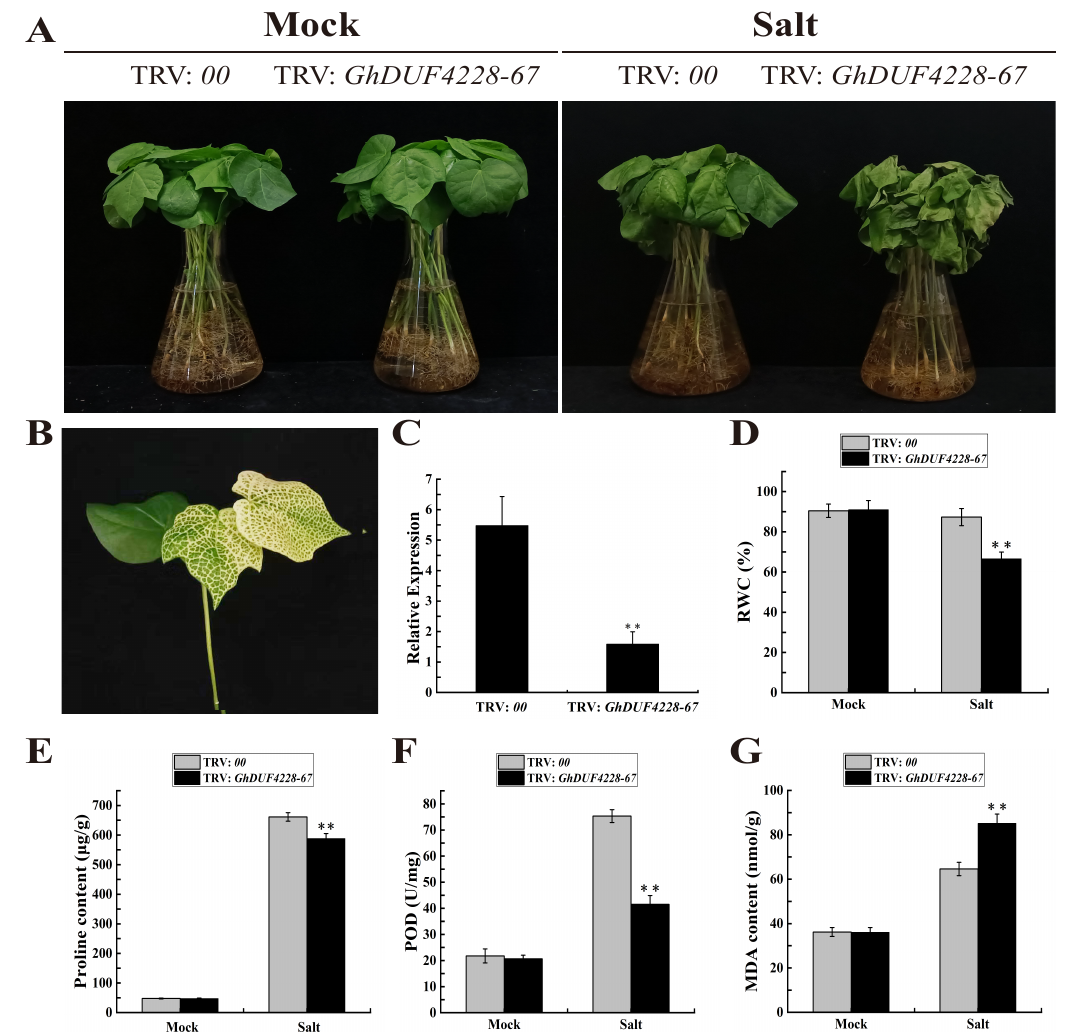
TRV: 00 plants (Figure 8E), the POD activity was only 1/2 of the TRV: 00 plants (Figure 8F), while the MDA content of the gene-silenced plants was 20 nm/g higher than that of the TRV: 00 plants (Figure 8G). The content of MDA indirectly reflects the damage degree to plant cells, and POD is one of the key enzymes of the enzymatic defense system of plants under adverse conditions. Generally, the proline content of plants is low, but it accumulates in large quantities when under stress, and the accumulation amount is positively correlated with the stress resistance of plants. Combined with the analysis of the above experimental results, the silencing of GhDUF4228-67 may reduce the salt tolerance of cotton.